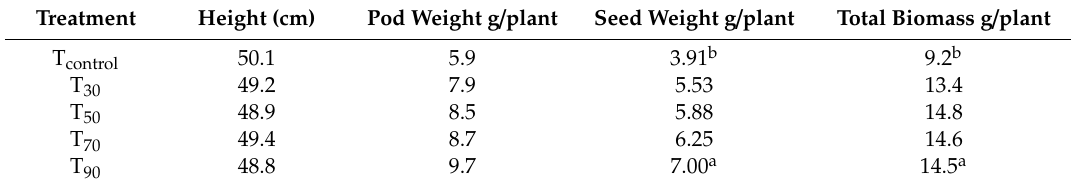
Table 3. Average measured height, pod and seed weight per plant, and obtained total biomass of soybean from irrigated treatment (T control ) and di ff erent applied water table depths. Treatment Height (cm) Pod Weight g / plant Seed Weight g / plant Total Biomass g /